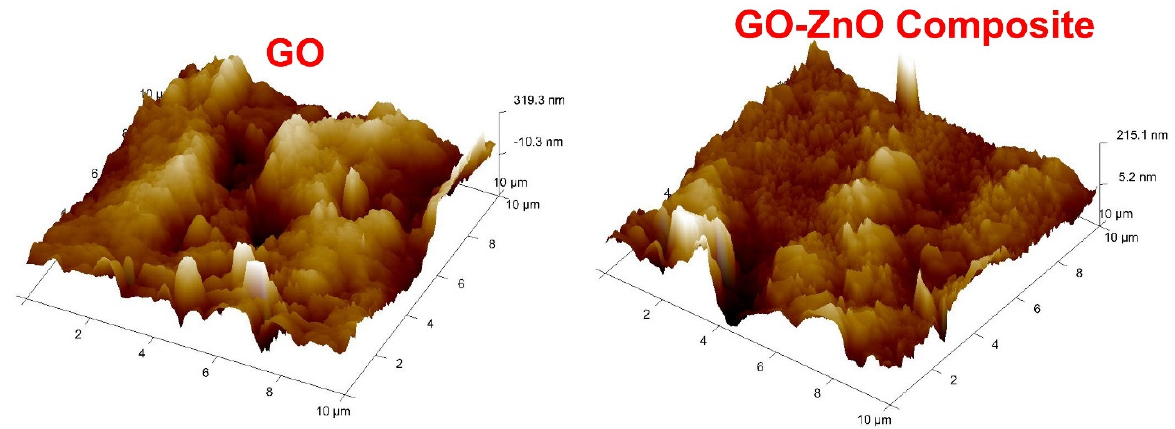
Figure 4. AFM image of (i) GO and, (ii) GO-ZnO composite.